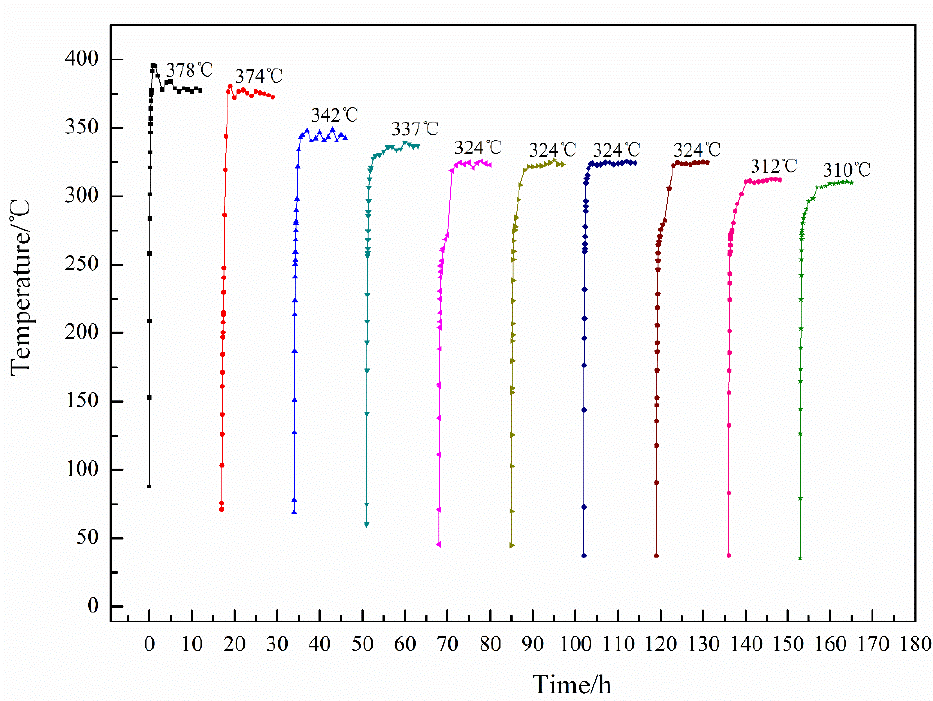
Figure 12. Temperature – time curves of the cyclic electrification test of heat-treated coatings.